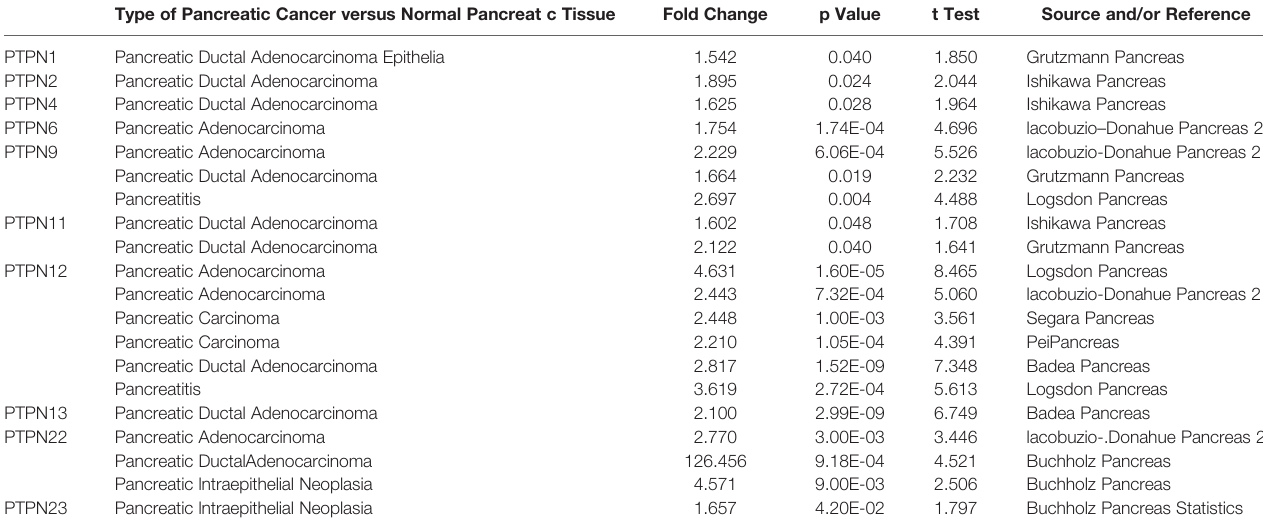
TABLE 1 | Signi fi cant Changes of PTPN Expression in Transcription Level between Different Types of Pancreatic Cancer and Normal Tissues (Oncomine Database). Type of Pancreatic Cancer versus Normal Pancreat c Tissue Fold Change